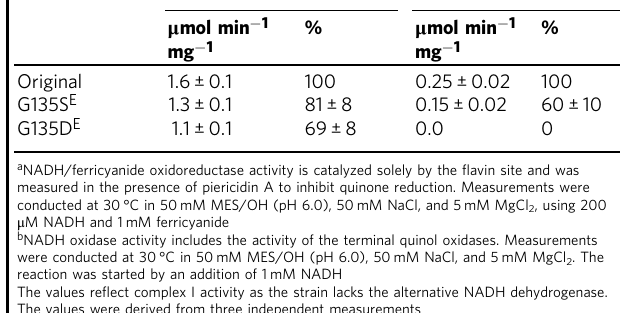
con fi rmed to contain the subunits of E. coli complex I (Supplementary Fig. 5, Supplementary Table 4). Each preparation contained 0.94 ± 0.1 mol FMN/mol protein. The midpoint potential of FMN in the preparations was determined to E m,7 = − 318.0 ± 6.0 mV. The midpoint potential of N1a was not signi fi cantly changed from − 245 ± 20 mV to − 235 ± 20 mV by the mutation. The stability of the fl avin site of NuoF was assessed using a “ ThermoFAD ” protocol 27 . The “ melting temperature ” of the E. coli complex I variants G135S E and G135D E were determined to 64 and 63 °C, respectively, and are, thus, very similar to that of the original protein with 69 °C (Supplementary Fig. 6). EPR-spectroscopy con fi rmed the